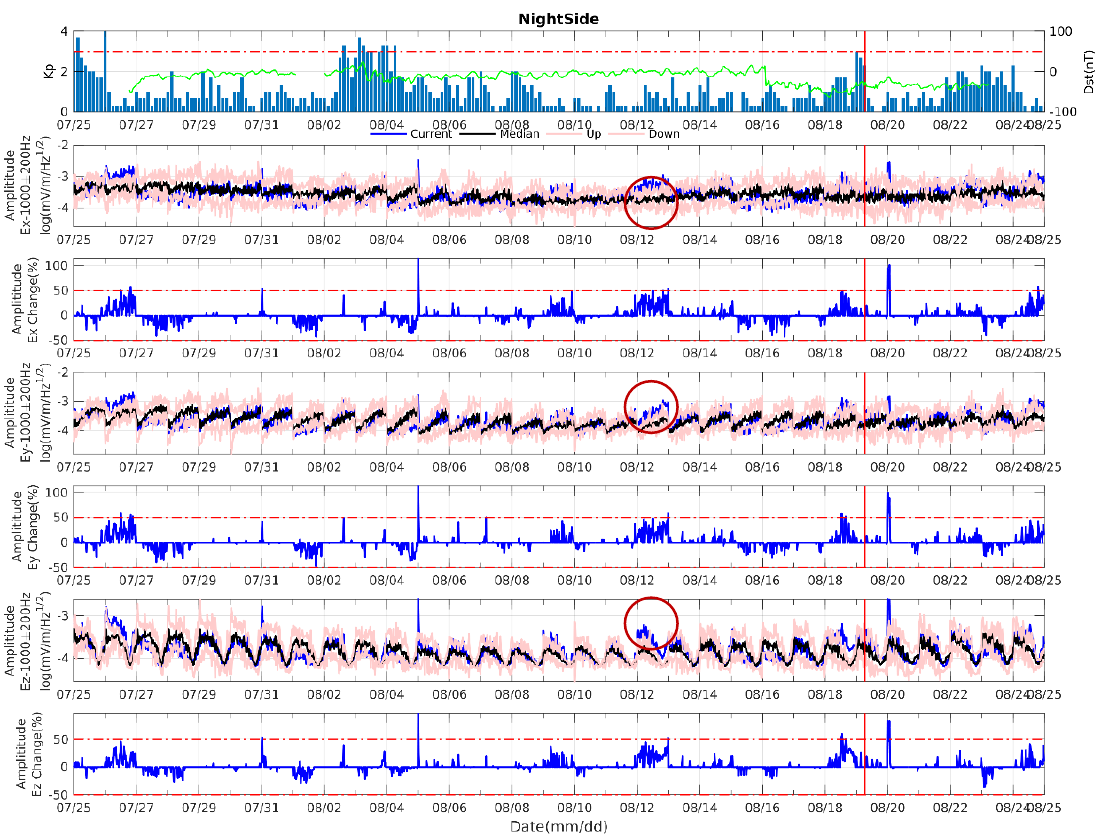
Figure 4. The electric field variation in frequency at 1000 ± 100 Hz during 18 August 2020, M 7.0 Sumatra EQ. The space weather index Kp is presented by blue bars, and the Dst index is displayed by the cyan curve. The red horizontal dashed line represents the values of Kp =